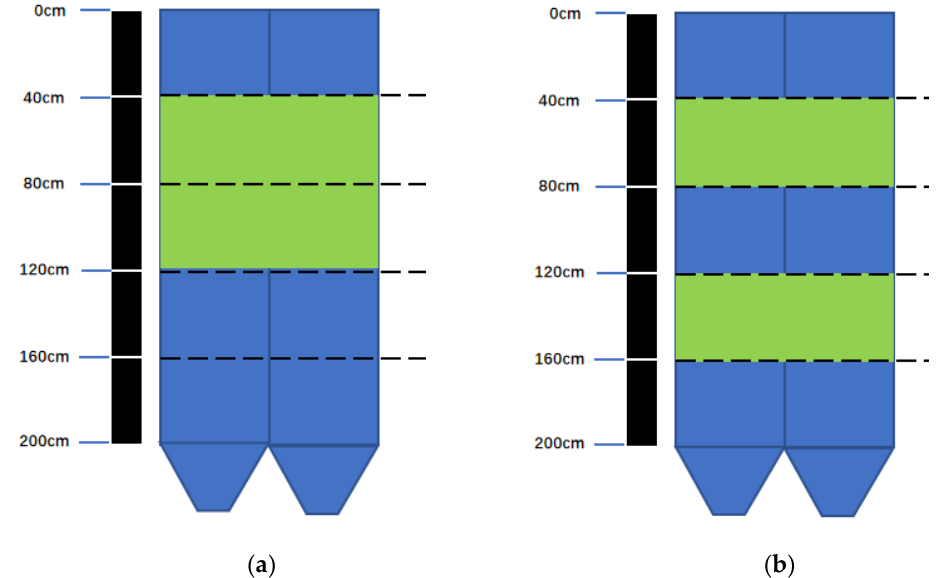
Figure 2. Two different vegetation cover modes: ( a ) VFS with whole piece named VFS1; ( b ) VFS with two pieces named VFS2. Note: the green stands for vegetation filter; and the blue stands for bare ground.